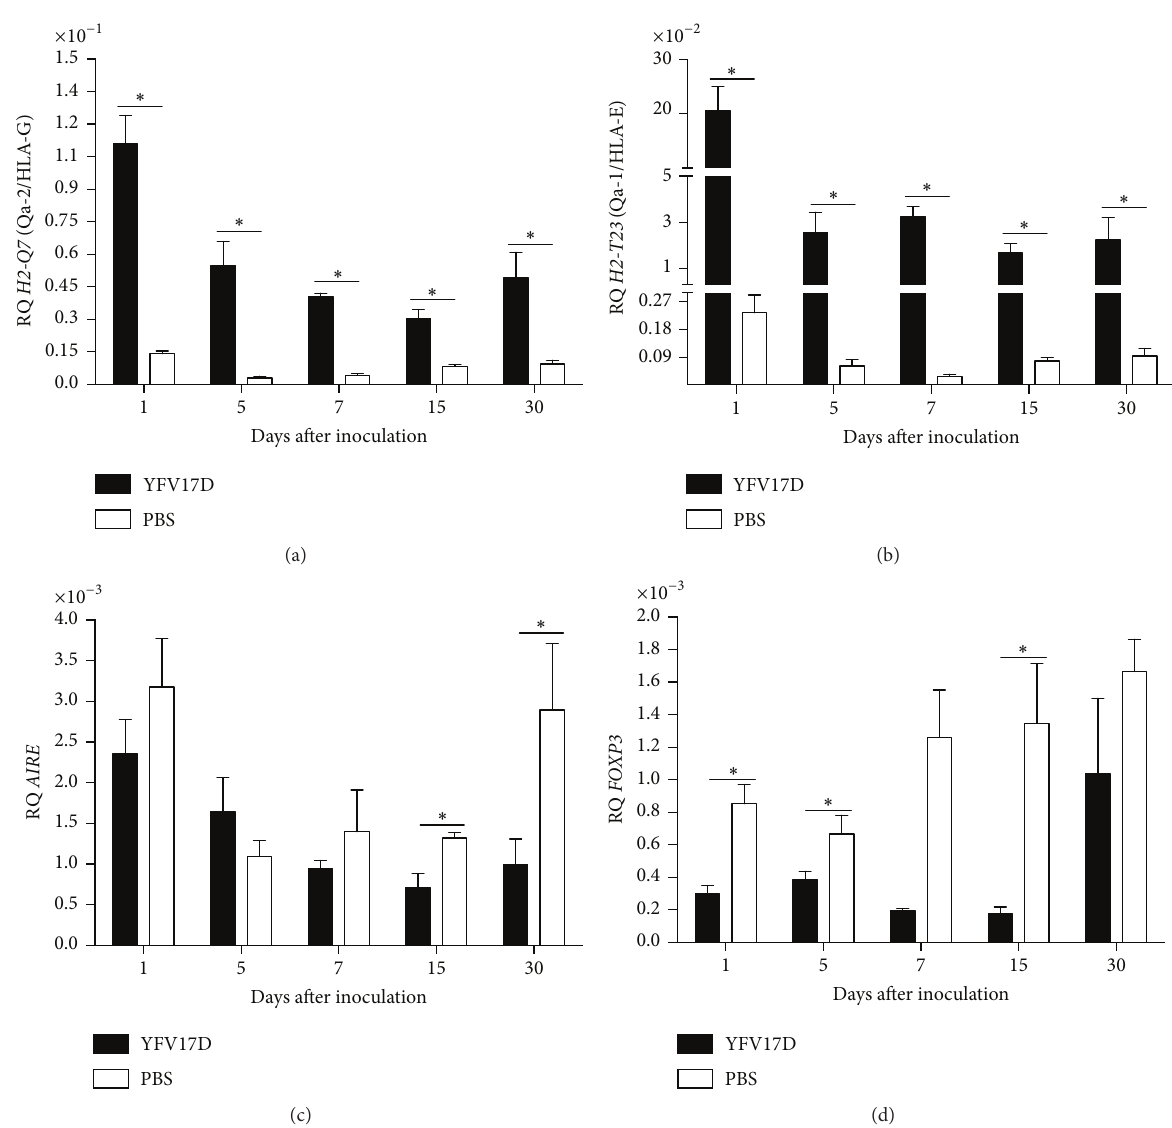
Figure3:Geneexpressionofimmunomodulatorymolecules:(a) H2-Q7 (Qa-2/HLA-G);(b) H2-T23 (Qa-1/HLA-E);(c) AIRE ;and(d) FOXP3 in thymus of BALB/c mice inoculated with 10.000 LD 50 of YFV17D or PBS. RQ = relative quantification representative of geometric mean values of 2 −ΔΔ Ct . Tissue samples were obtained in triplicate from different animals for each treatment. Each experiment was independently performed at least three times. Statistical analysis was performed using the nonparametric test Mann-Whitney two-tailed. Values close to the level of significance ( 𝑃 < 0.05 ) are marked with ∗